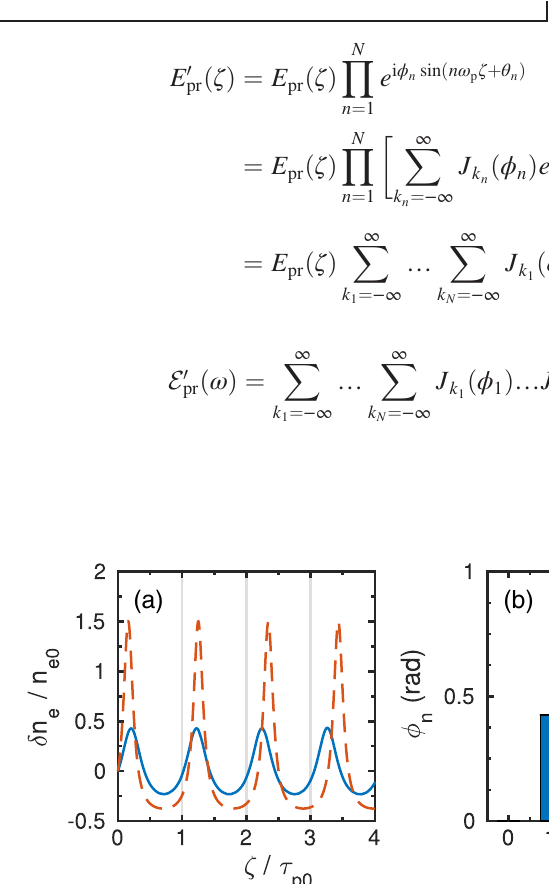
FIG. 3. (a) Calculated temporal behaviour of the relative density of quasi-linear plasma waves for β (b) Harmonic amplitudes ϕ of the phase shift experienced by a 400 nm probe pulse copropagating for 1 mm with the plasma waves n shown in (a). (c) Calculated TESS signals for the plasma waves in (a) and the phase shifts shown in (b) at β 0 . 6 and β m ¼